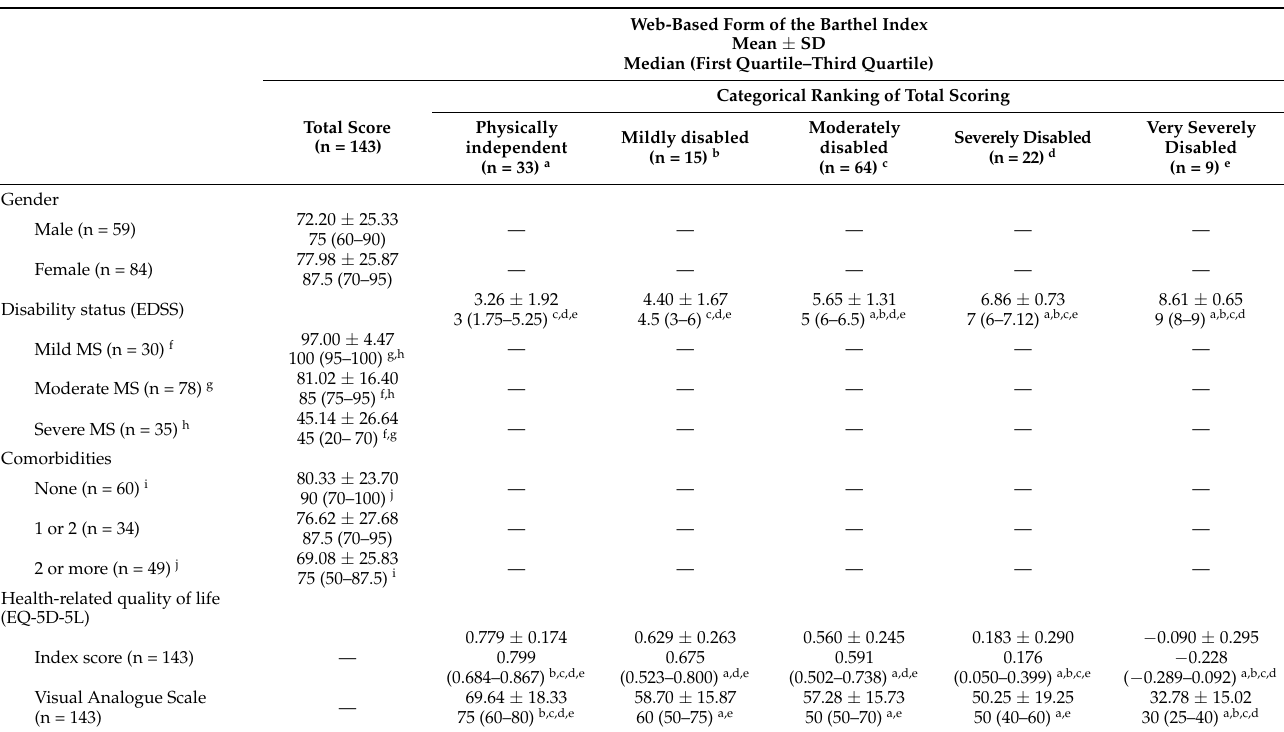
EDSS, Expanded Disability Status Scale; EQ 5D-5L, European Quality of Life-5 Dimensions; MS, Multiple Sclerosis; SD Standard Deviation. Superscript letters (from “a” to “j”) indicate the groups in which statistically